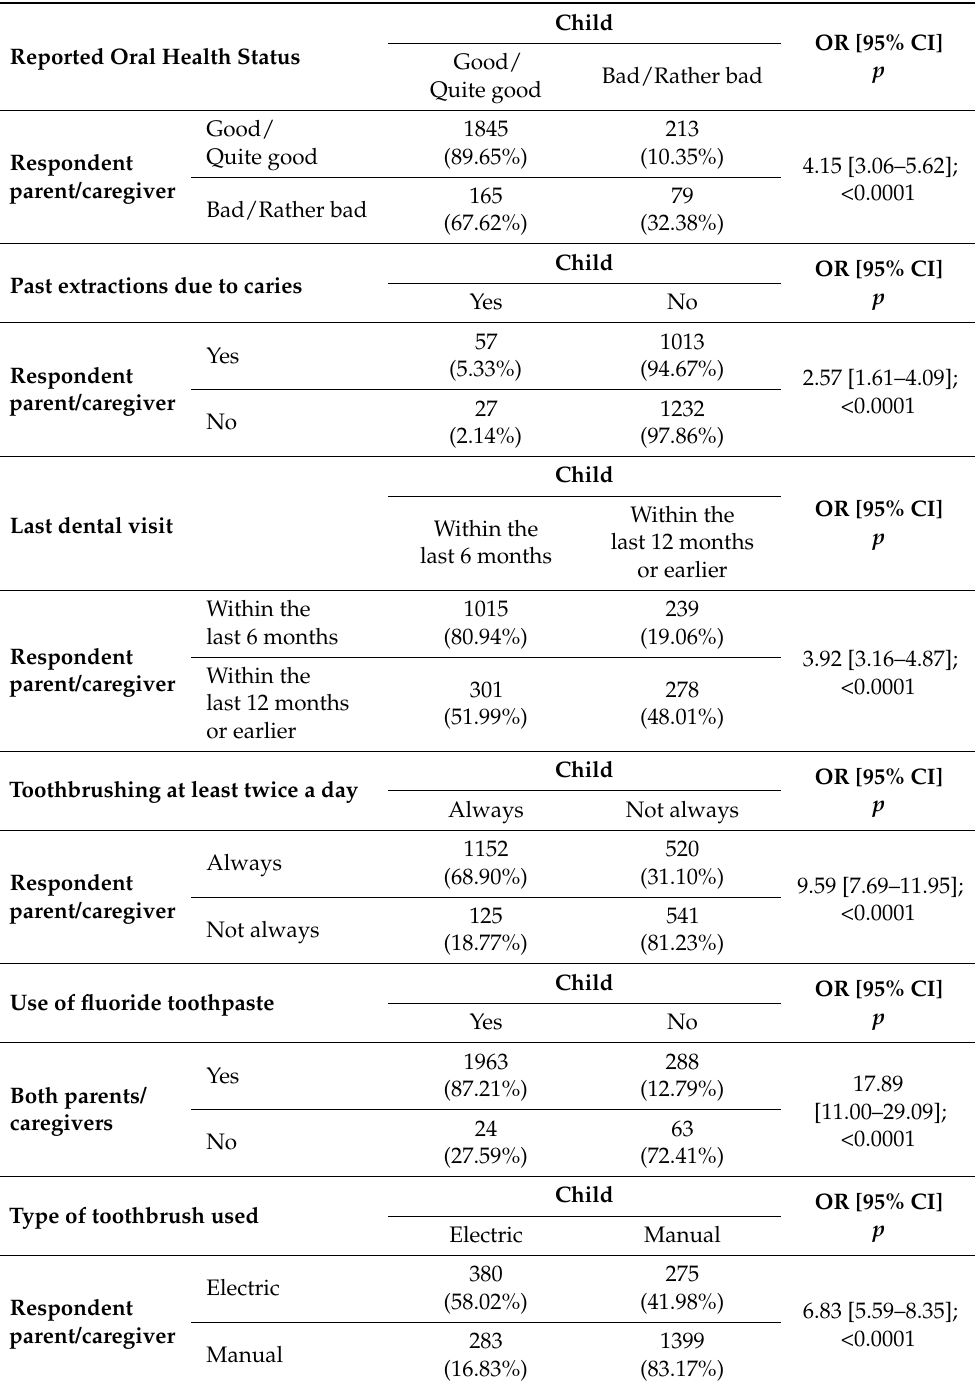
Table 5. Oral health status and practices: parents/caregivers vs.